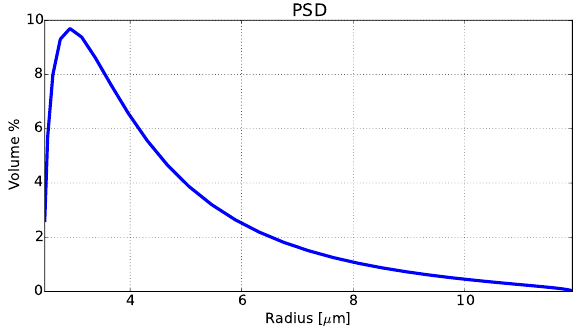
Figure 9. PSD simulating an isolated